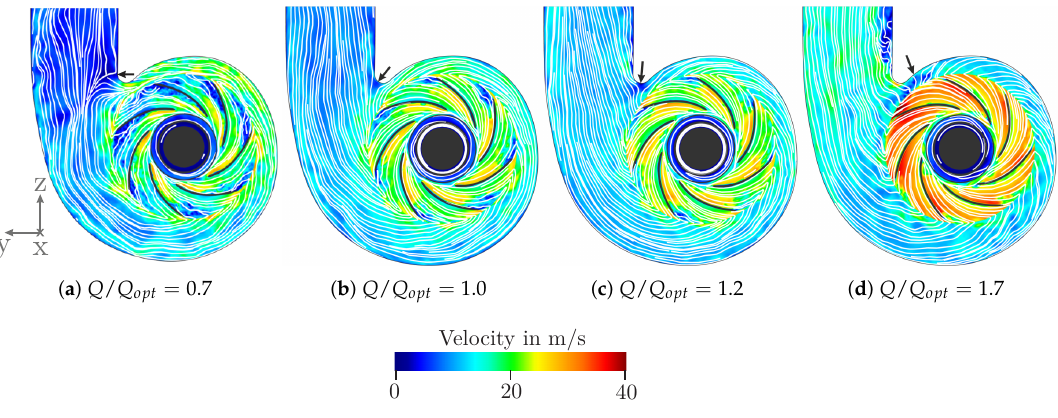
Figure 12. Instantaneous velocity with respect to the containing reference frame superimposed with projected streamlines on the plane shown in Figure 11; the black arrow mark the stagnation point.